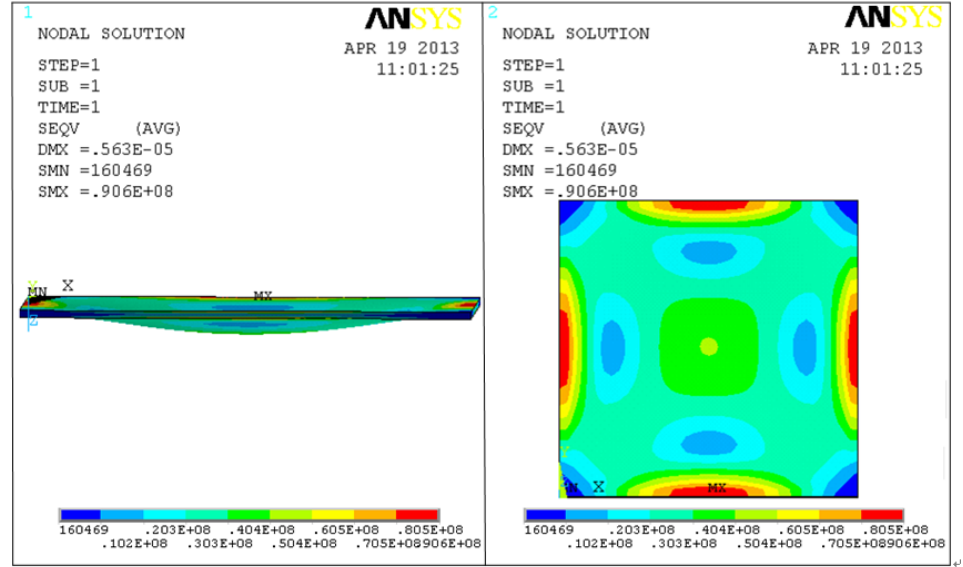
Figure 3. ANSYS simulation of membrane deflection under 0.1 MPa.